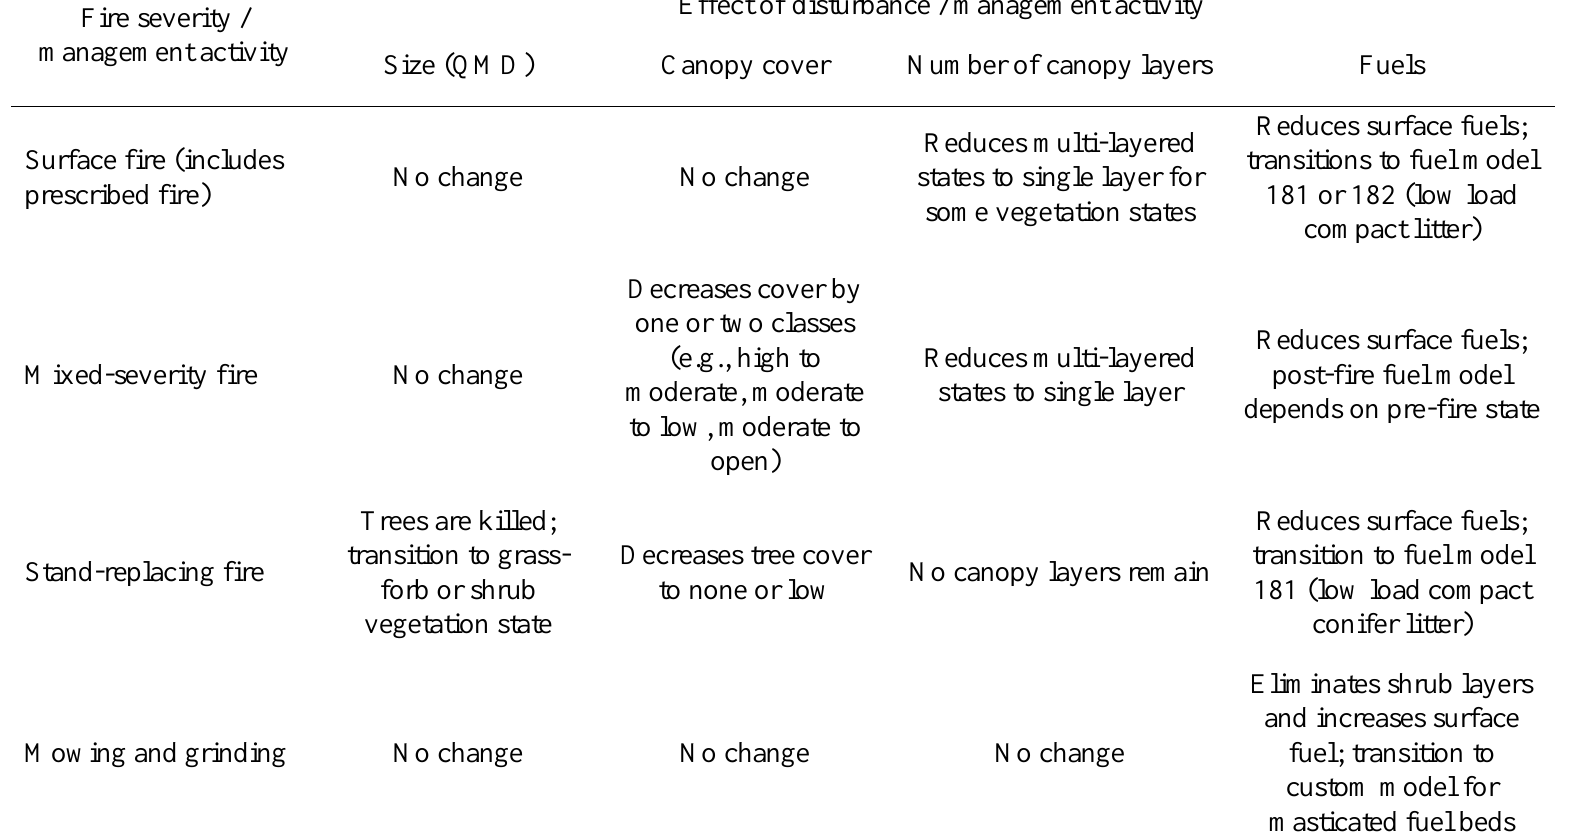
Table A1.1. Effect of fire severity and management on average tree size, canopy cover, layering, and fuels in state-transition vegetation classes. QMD = quadratic mean